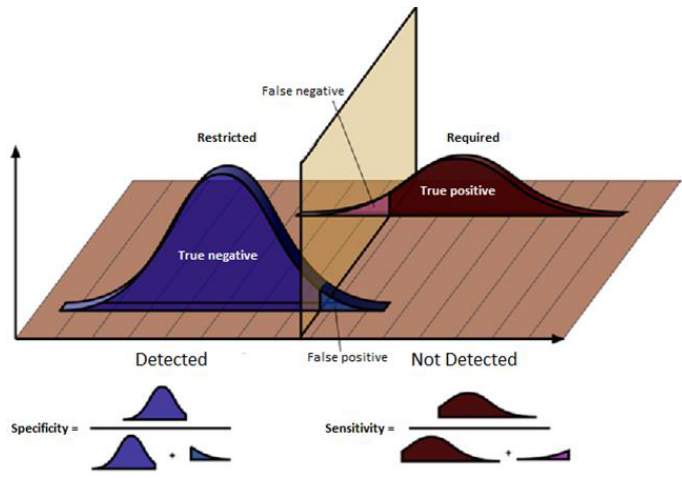
Figure 30. Sensitivity and specificity diagram.